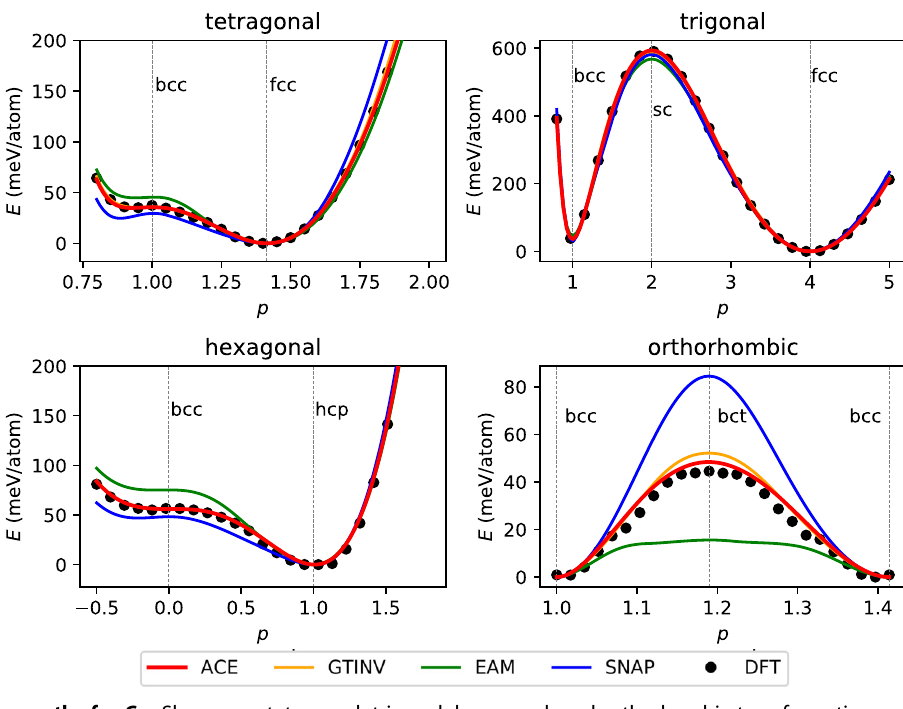
Fig. 3 Transformation paths for Cu. Shown are tetragonal, trigonal, hexagonal, and orthorhombic transformation paths.